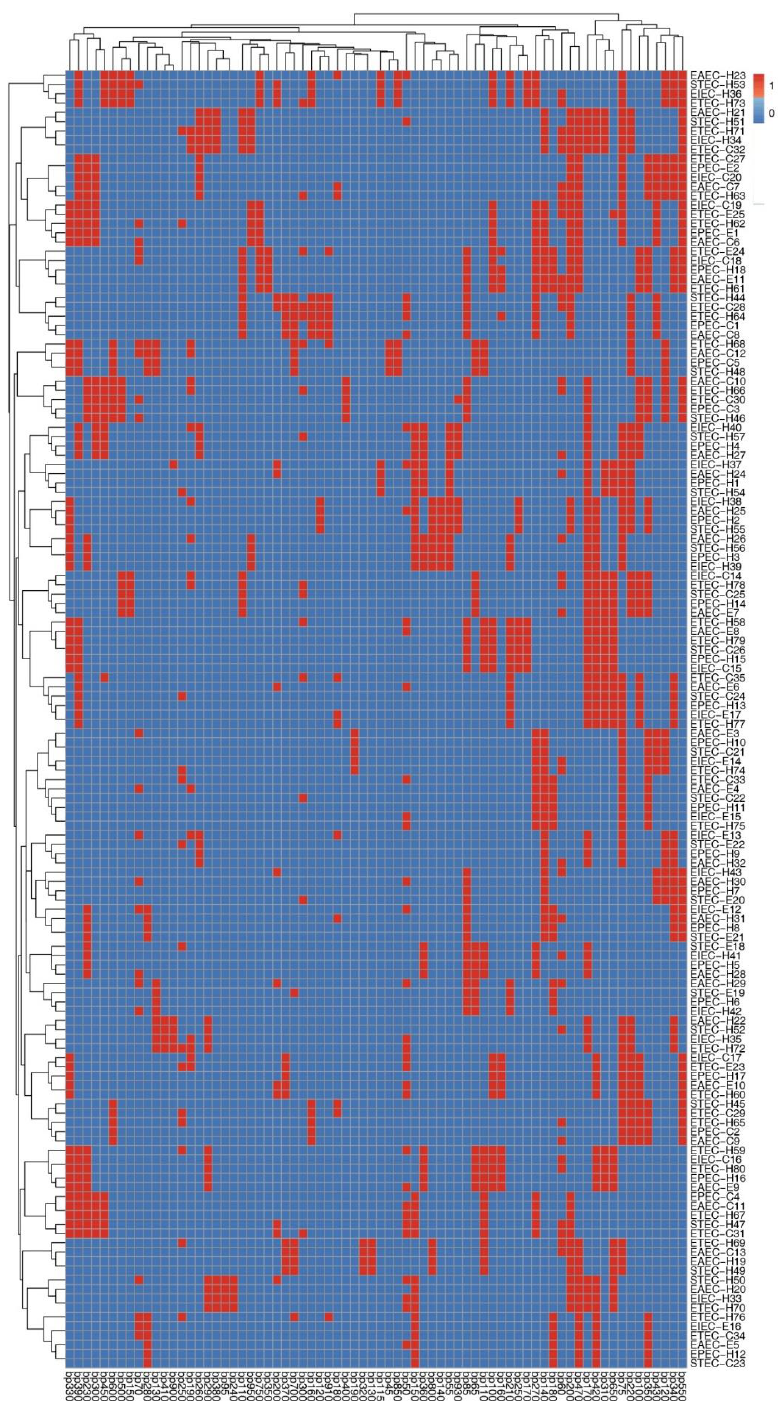
Figure 6. Heat map and hierarchical clustering of diarrheagenic E. coli pathotypes, according to the generated ERIC-PCR amplicon size (bp) profiles. Blue and red colors indicate the absence and presence of particular ERIC-PCR bands, respectively. The code numbers on the right side of the heat map denote the numbers of diarrheagenic E. coli pathotypes from equine (E), cow (C), and human (H) sources. TZP: piperacillin/tazobactam, C: chloramphenicol, TE: tetracycline, AMP: ampicillin,